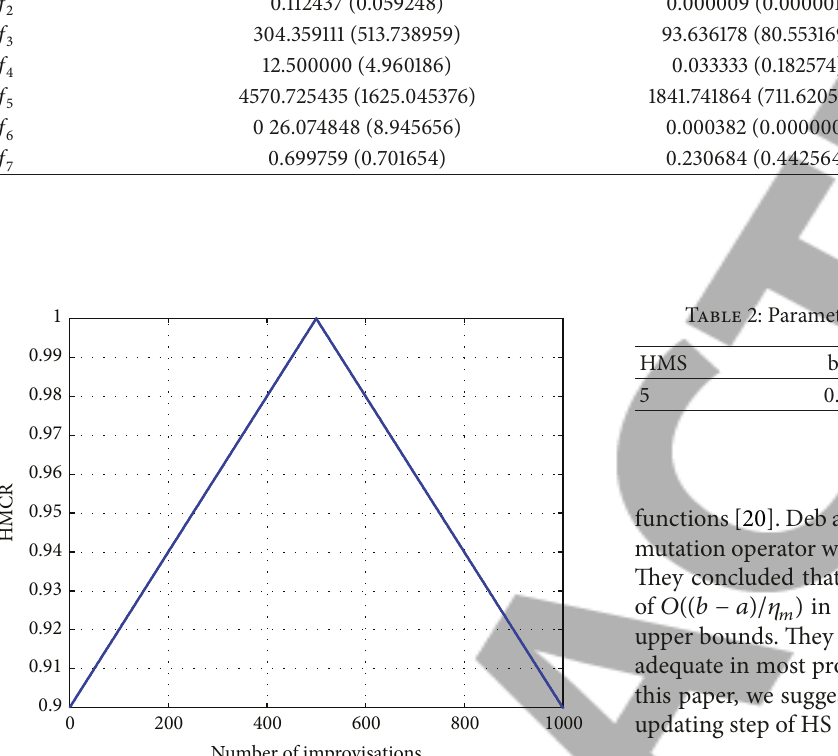
Figure 1: Variations of HMCR with respect to improvisations.